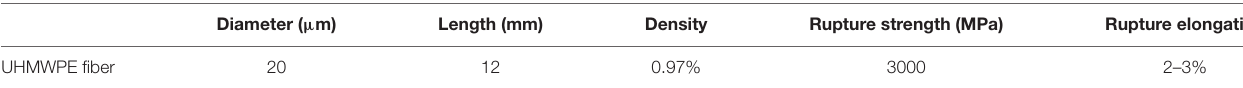
TABLE 3 | The geometry and mechanical properties of the used UHMWPE fibers.